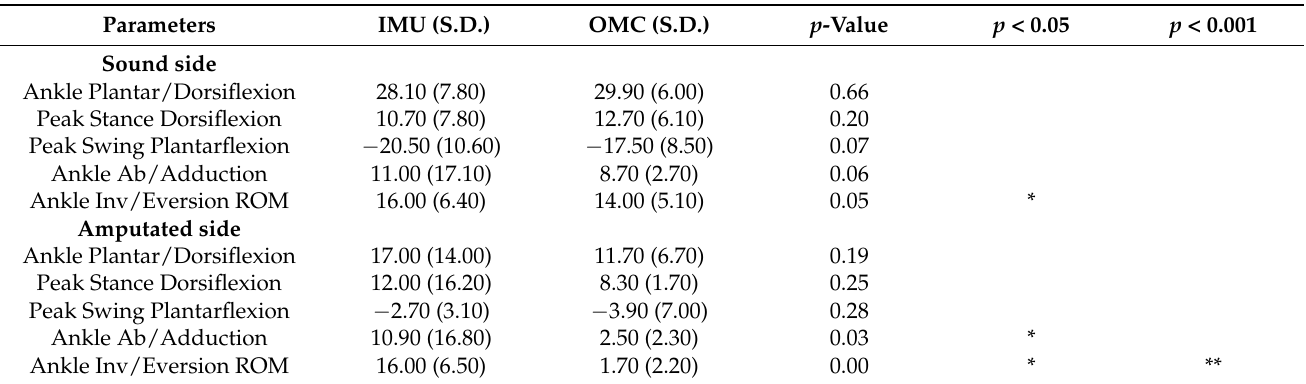
Table 6. Ankle joint angle parameters of thirty participants on sound and amputated side as mean (S.D.) over five gait cycles calculated by the IMU and OMC.